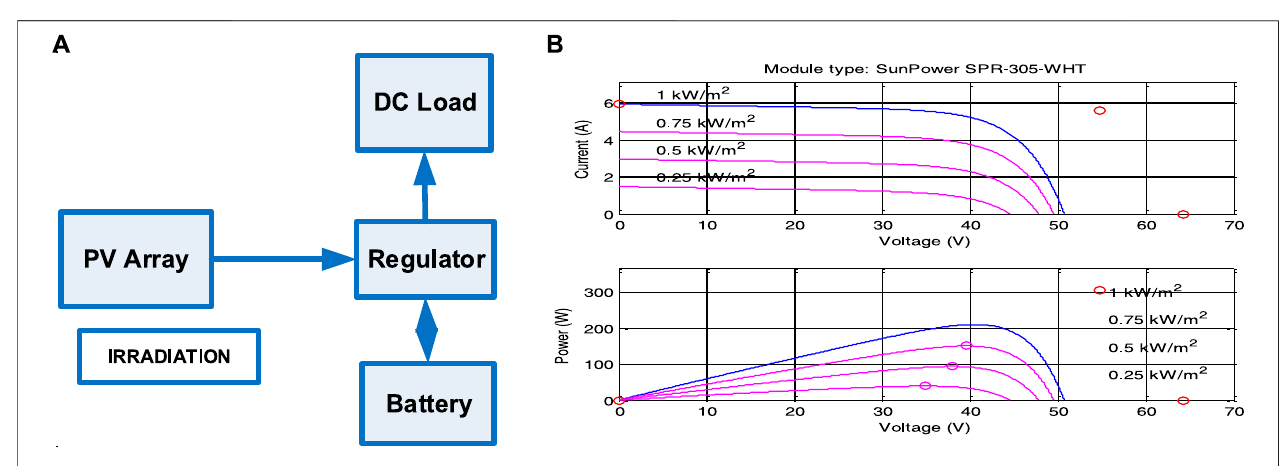
FIGURE 5 | (A) PV system and its operating blocks, (B) I-V and P-V based characteristics at 25 ° with changing radiation.